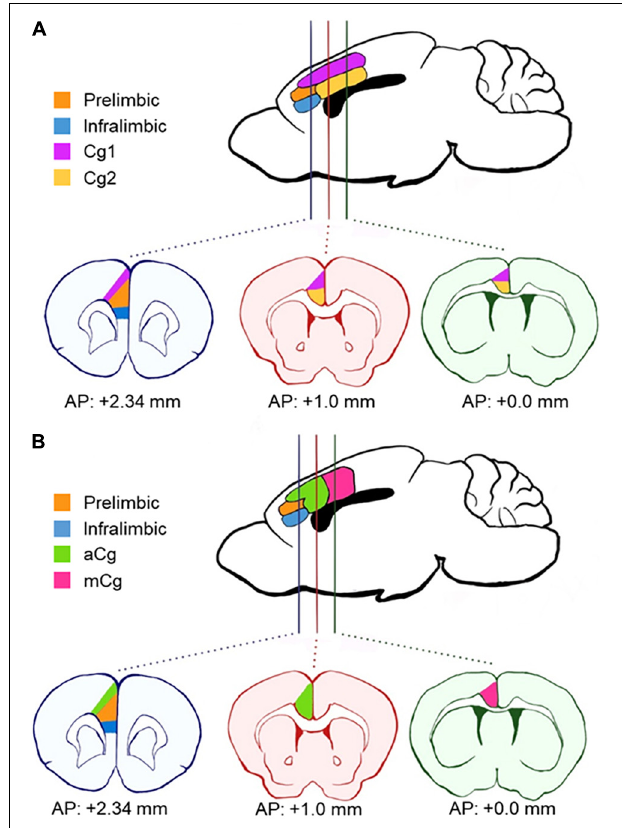
FIGURE 1 | Schematics of anatomical divisions in the prefrontal cortex. (A) Areas according to Paxino’s Mouse Brain Atlas (Franklin and Paxinos, 2013). The cingulate cortex is divided horizontally into two distinct regions across the coronal plane (Cg1 and Cg2). (B) Areas according to our definition, based on van Heukelum et al. (2020). Here, the cingulate cortex is divided into the anterior cingulate cortex (aCg) and mid-cingulate cortex (mCg) in the coronal plane. aCg and mCg both encompass regions Cg1 and Cg2 as defined by Paxino’s Atlas. AP, antero-posterior coordinates from